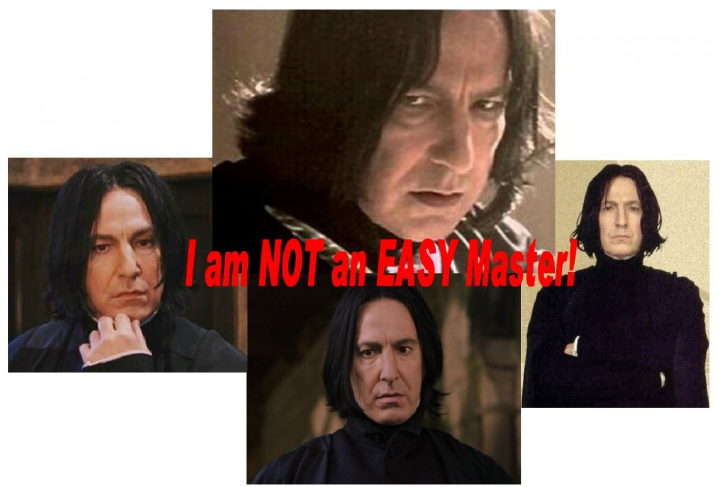
Figure 9. Snape is not an easy master, as composed by Rose